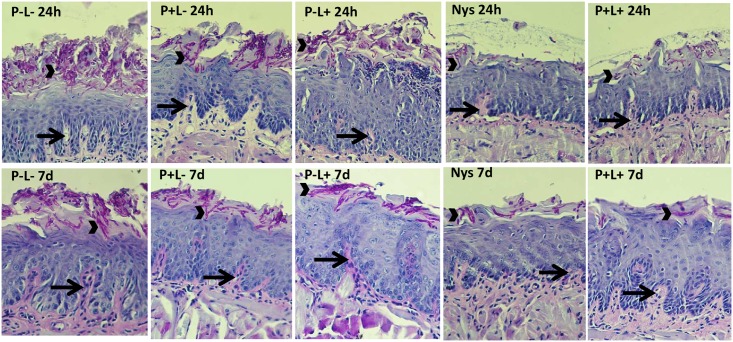
Representative images of histological sections showing a moderate inflammatory infiltrate (arrows) with innumerous hyphae/pseudohyphae (arrow head) on the keratin layer for the groups P-L-, P+L- and P-L+, and a mild inflammatory infiltrate (arrows) with a few hyphae/pseudohyphae (arrow head) on the keratin layer for the groups treated with NYS and P+L+ 24 hours (24h) and 7 days (7d) after treatment.